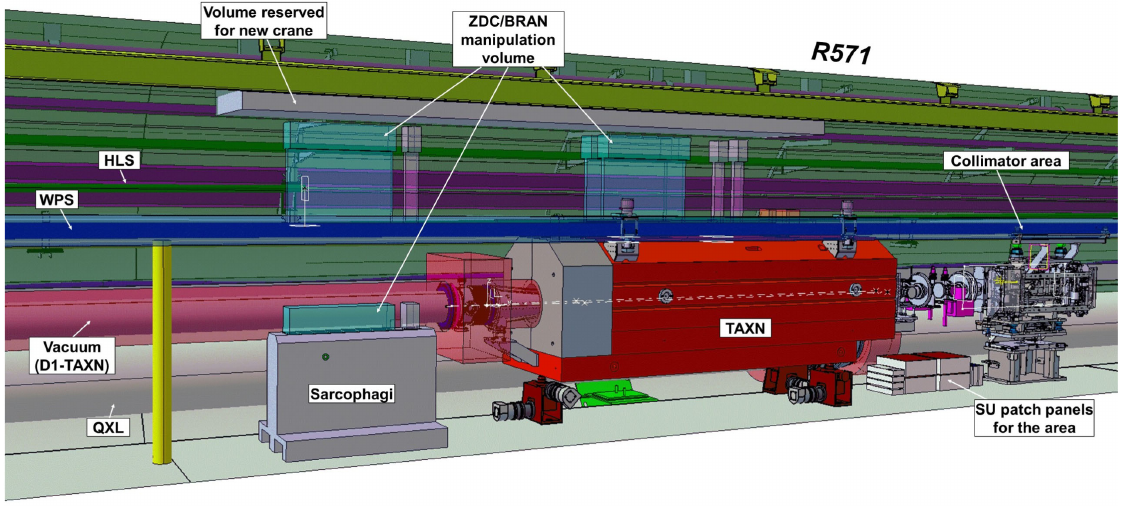
FIG. 4. TAXN integration inside the LHC tunnel.